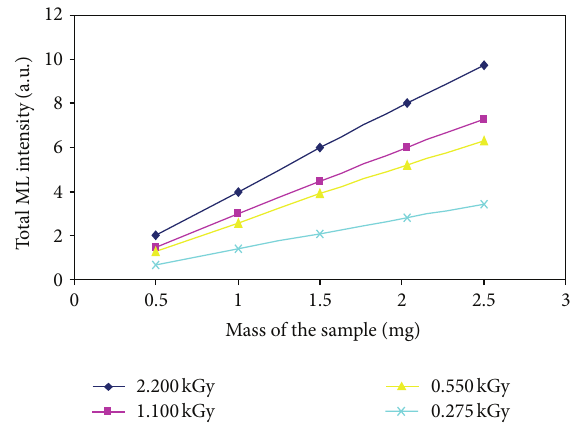
Figure 4: Dependence of ML intensity of MgAl 2 O 4 : Dy (0.1mol%) phosphor on mass of the phosphor for different gamma dose.